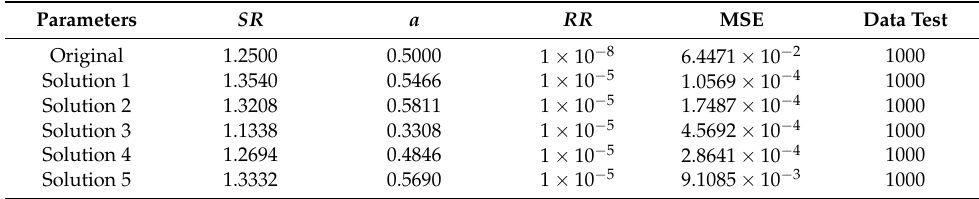
Table 4. ESN optimization using PSO to predict the time series of the Lorenz system.